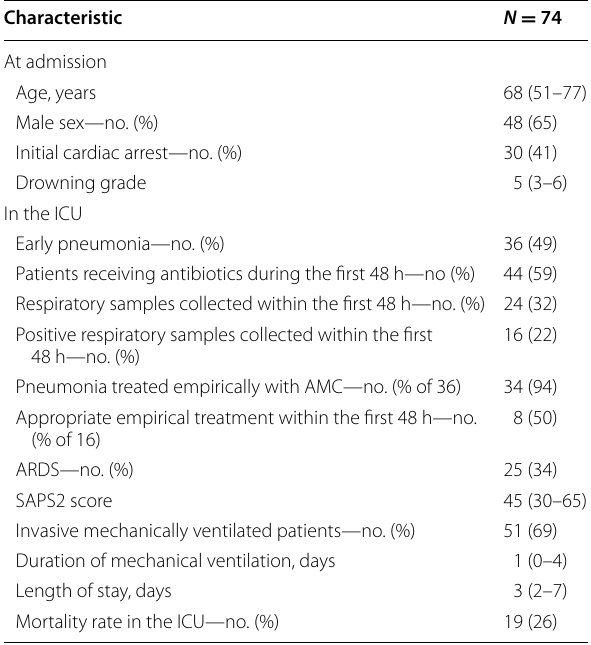
Table 2 Demographics and clinical characteristics of the